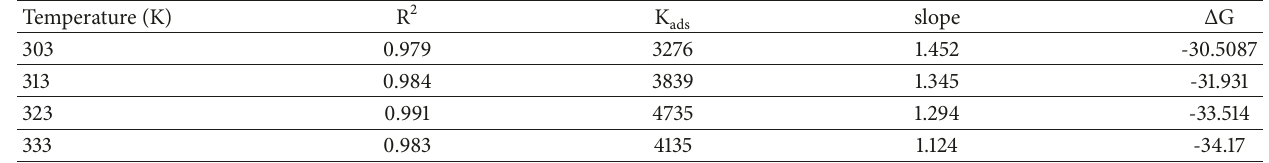
Table 5: Equilibrium and statistical parameter for adsorption of MFC on Brass surface in 1M